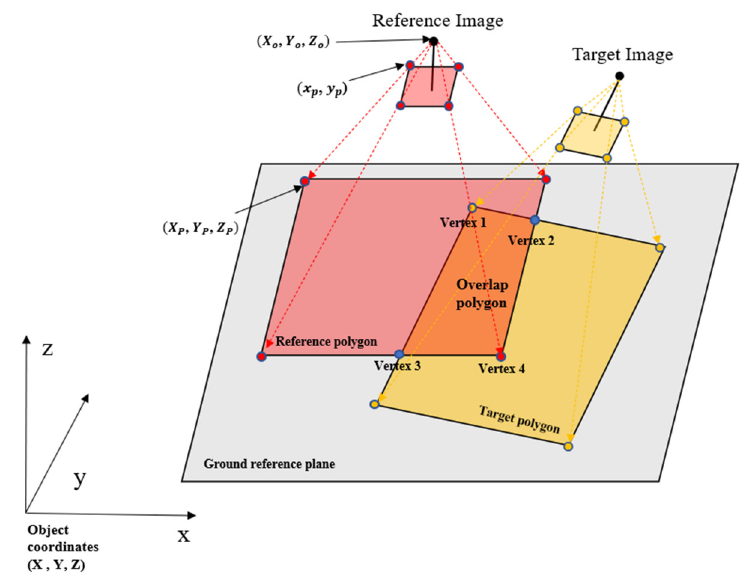
Figure 3. An overlap area in ground space .